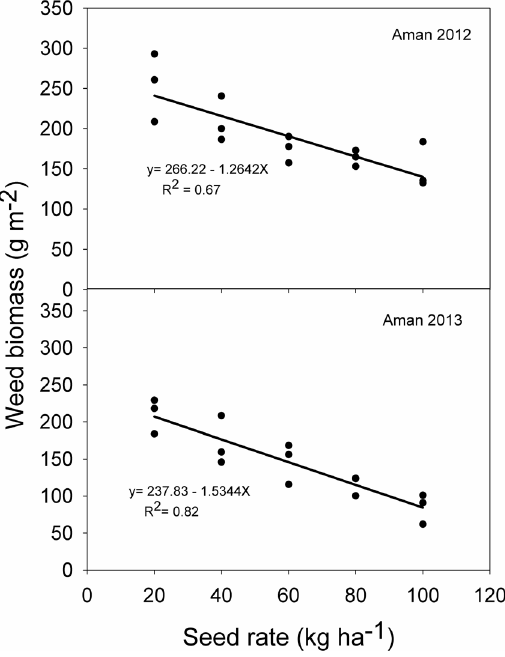
Rice Panicle The interaction between weed infestation level and seeding rate had a significant effect on the number of rice panicles in both seasons (Figure 5). In both partially-weedy and weed-free